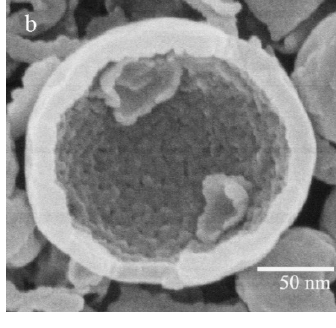
Figure 4. Electron micrographs of ( a ) silica - based nanocapsules by FE - SEM, ( b ) broken capsules by FE - SEM, ( c ) by TEM.